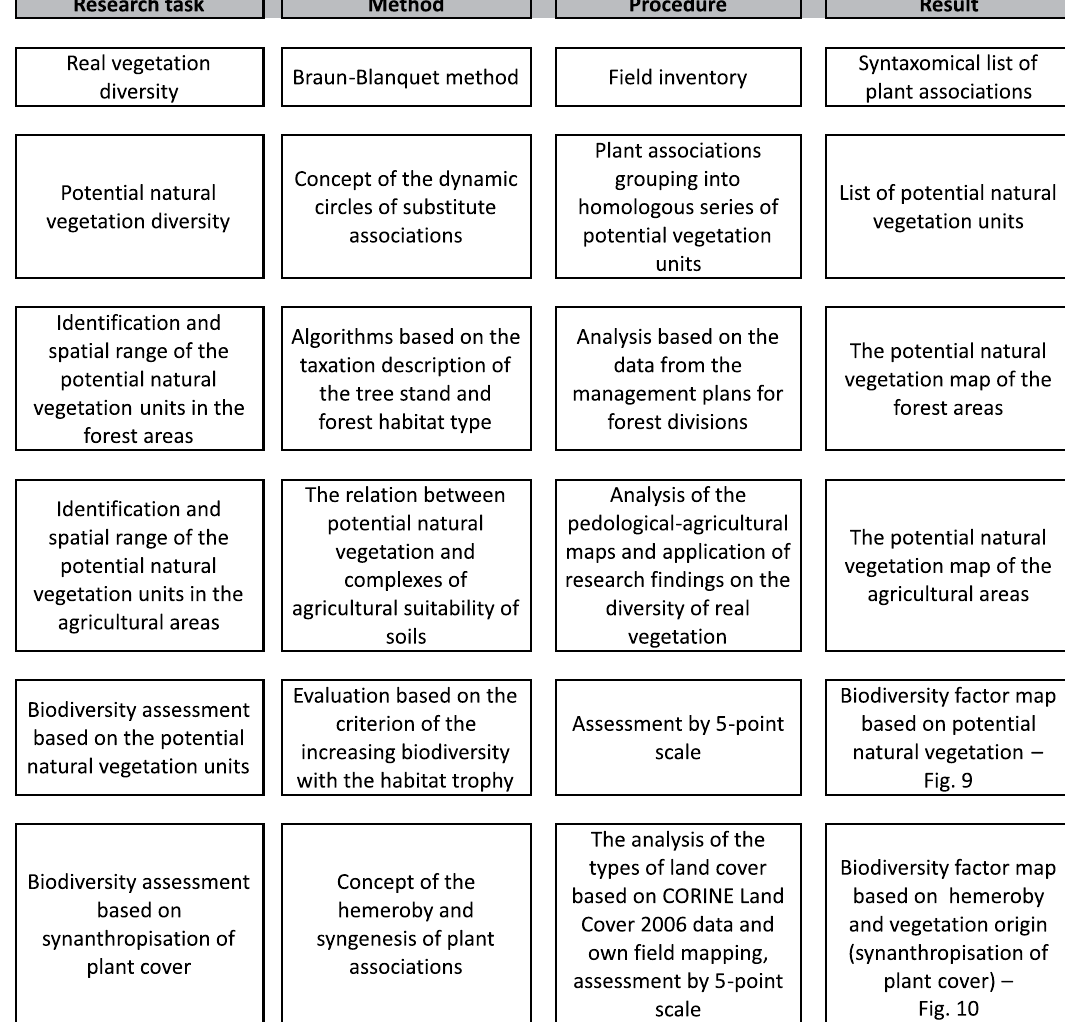
Fig. 2. The Scope and methods of biodiversity